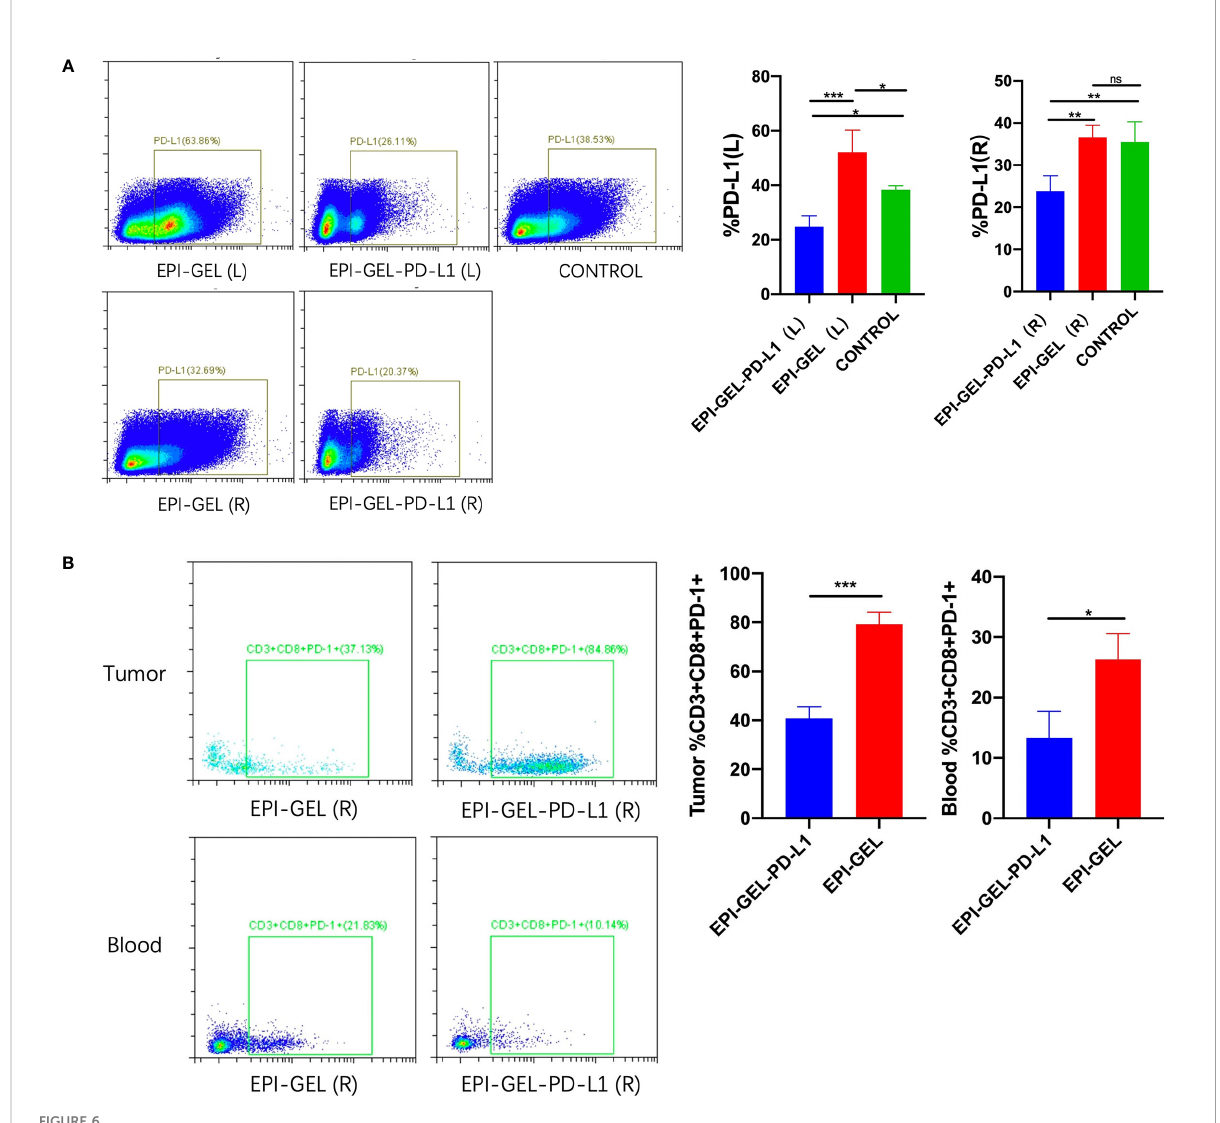
FIGURE 6 Representative fl ow cytometry analysis of PD-L1 + (A) and CD3 + CD8 + PD-1 + (B) cell in fi ltration in bilateral tumors and blood from mice treated with epirubicin (EPI) gel alone or in combination with anti-programmed death ligand 1 (PD-L1). ns, not signi fi cant. *p < 0.0332, **p < 0.0021, ***p < 0.0002, ****p < 0.0001 (one-way ANOVA with Tukey ’ s test/ unpaired t